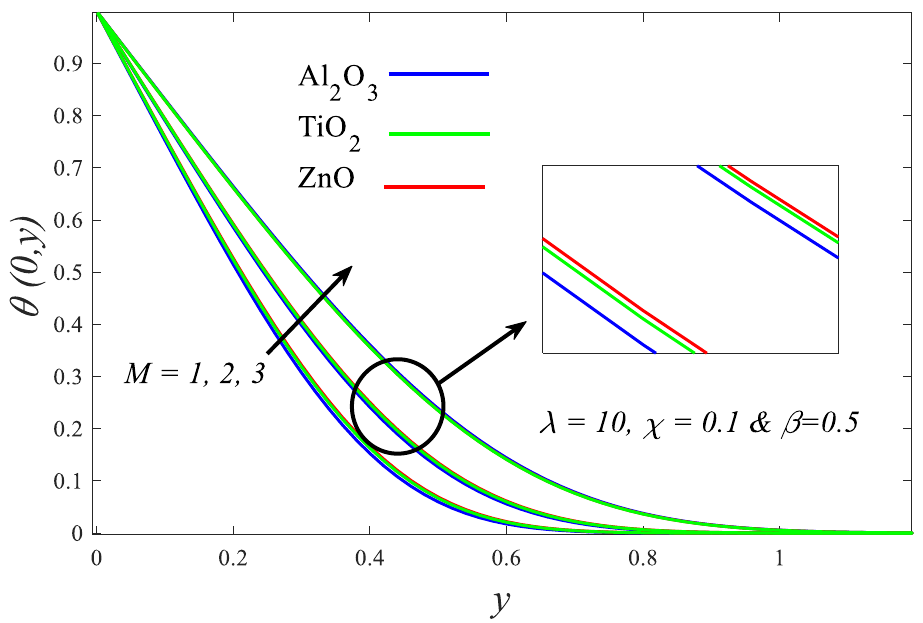
Figure 16. Impression of M on θ . The inset is a partial enlargement of the